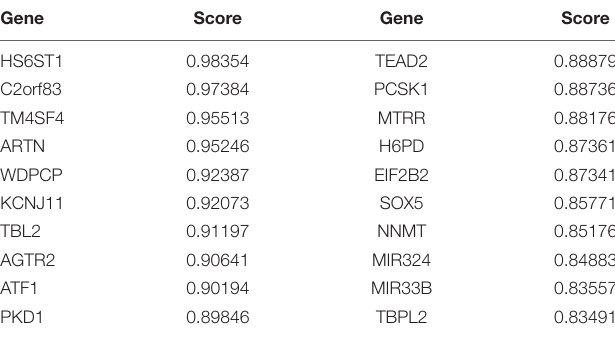
TABLE 1 | Top 20 predicted genes associated with ovarian cancer